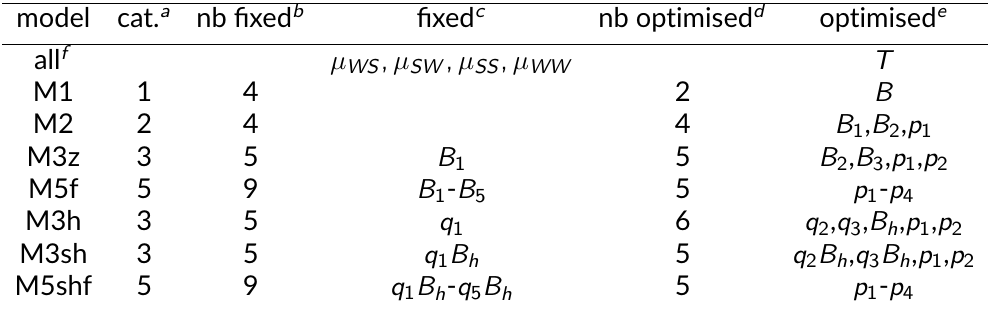
Table 1 – Parametrisation of the models used in this analysis. a : number of categories of genes; b : number of fixed parameters; c : list of fixed parameters; d : number of optimized parameters; e : list of optimized parameters; f : parameters shared by all